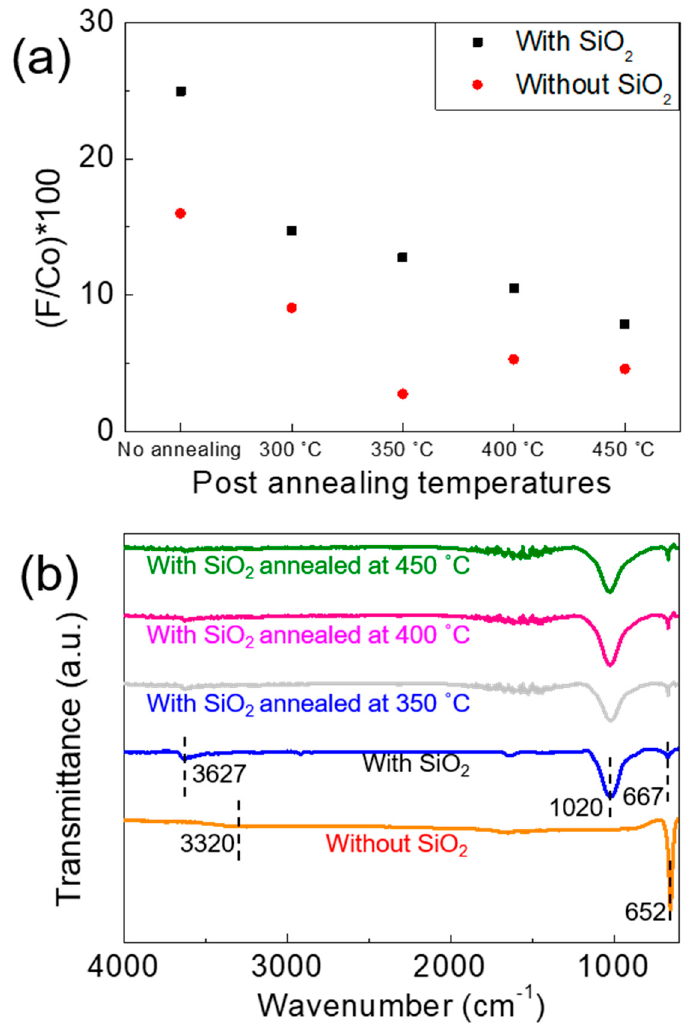
Figure 6. ( a ) Annealing temperature effects on the contents of fluorine (F/Co*100), acquired from XPS, in the nanosheets synthesized with and without SiO 2 template, and ( b ) comparison of the Fourier transform infrared spectroscopy (FTIR) spectra of the samples.